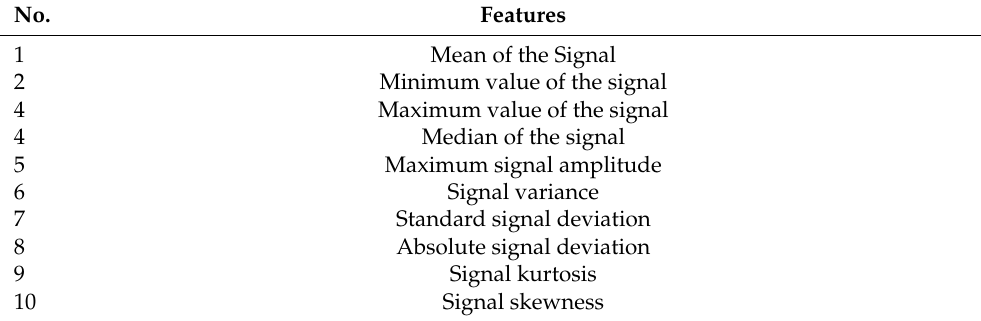
Table 3. Statistical